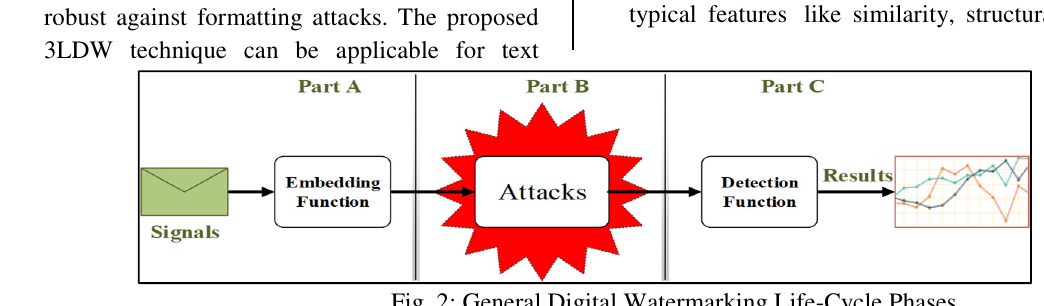
Fig. 2: General Digital Watermarking Life-Cycle